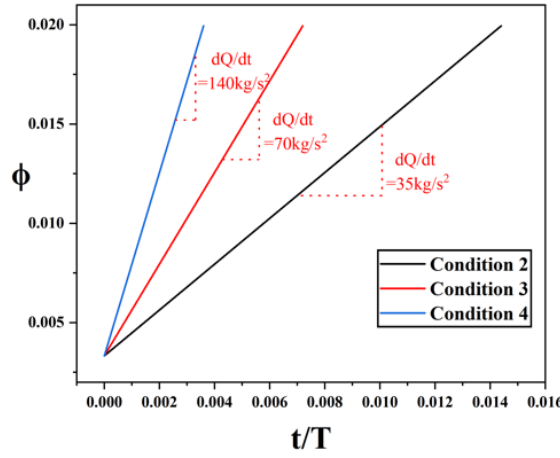
Figure 10. Comprehensive flow rate change law for various conditions.